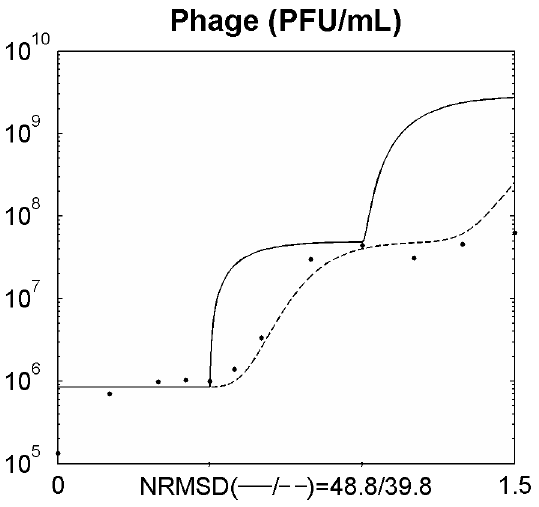
Figure 1. Simulating the one step growth curve using a normal distribution function (equations 6–14). Legend: N experimental data; … data from the model using the average value of the latent period (equations 6–12); ___ data from the model using a distribution of values of the latent period (introduction of equations 13 and 14). The x axis represents time in